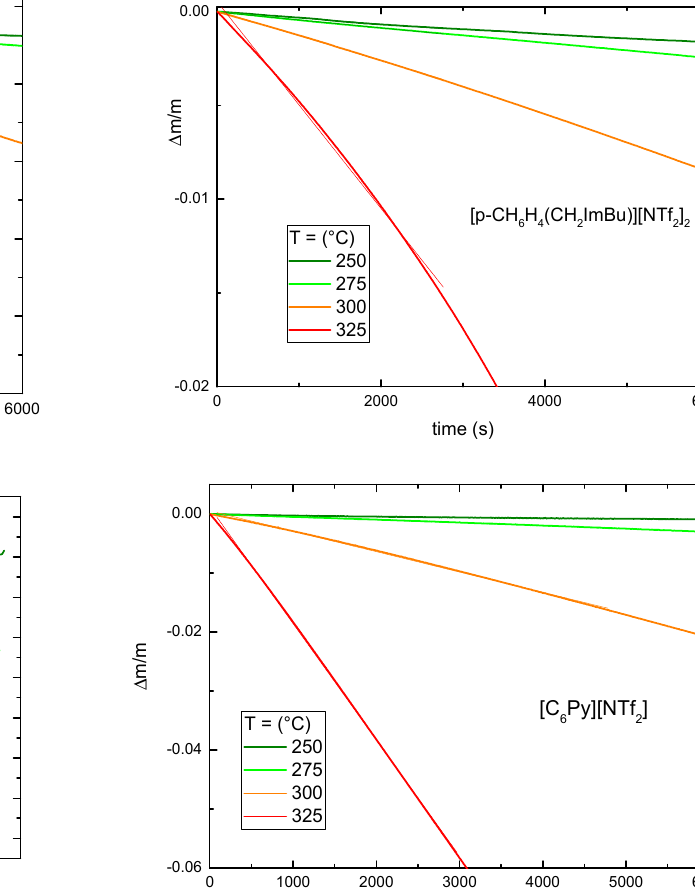
Figure 2. DSC traces measured on heating of the investigated ionic liquids.